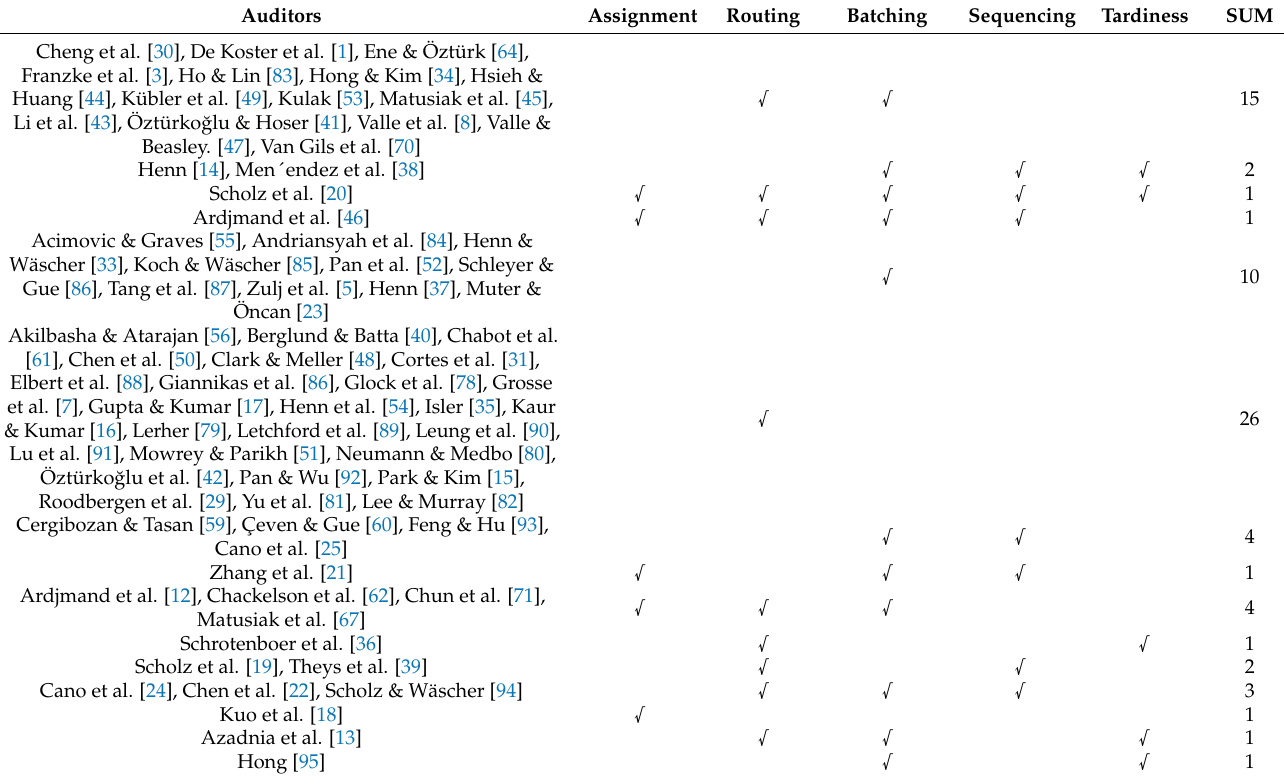
Table 4. Areas of Study in the Picking